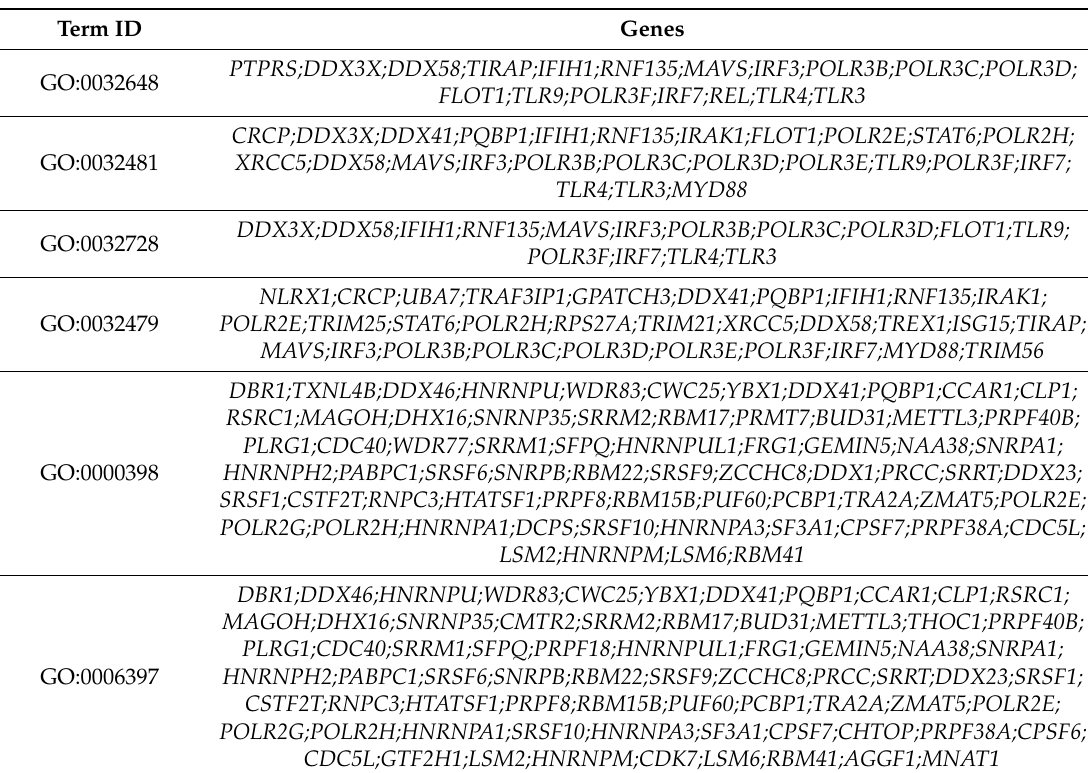
Table A1. Gene lists for GO Biological Processes terms. The listed genes are di ff erentially expressed genes in treated vs. untreated 4T1 cells overlapping with genes in the GO term lists as analyzed with Enrichr